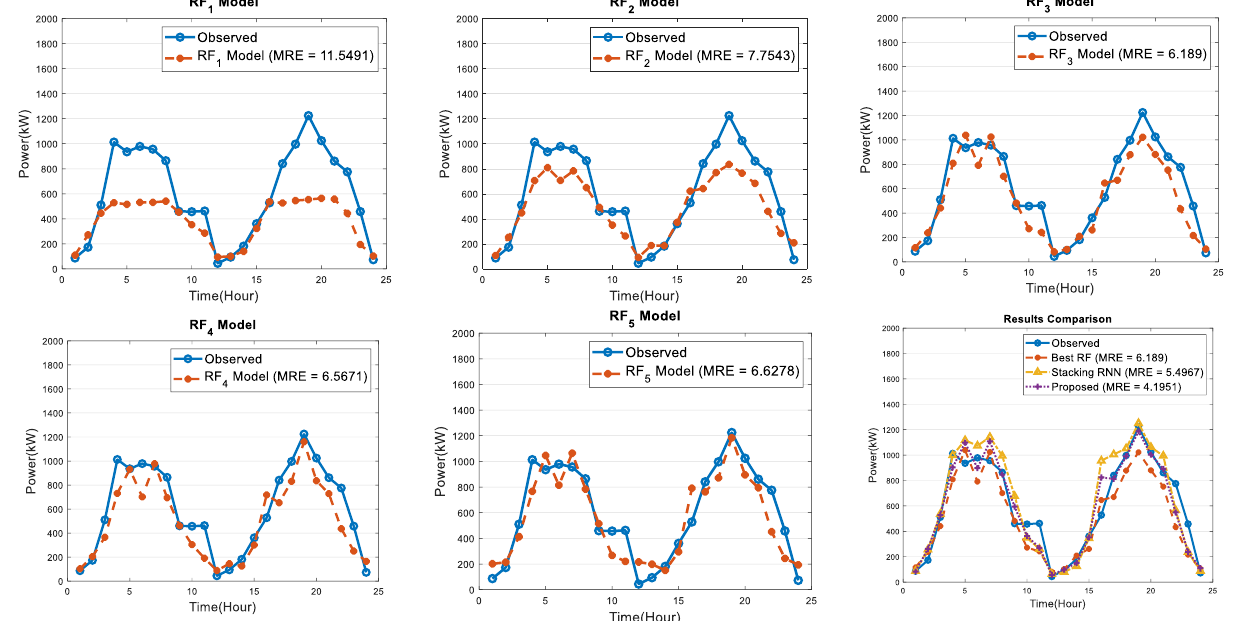
Figure 11. Results for one-day-ahead PV power forecasting for cloudy weather conditions. The results for the RF models and the proposed regression-based ensemble forecasting method for heavy-cloudy weather conditions are shown in Figure 12. The RF 3 model has the lowest MRE value of 4.62% compared to the other RF models. With an MRE value of 4.4%, the stacking RNN outperforms the best RF model in forecasting PV power.